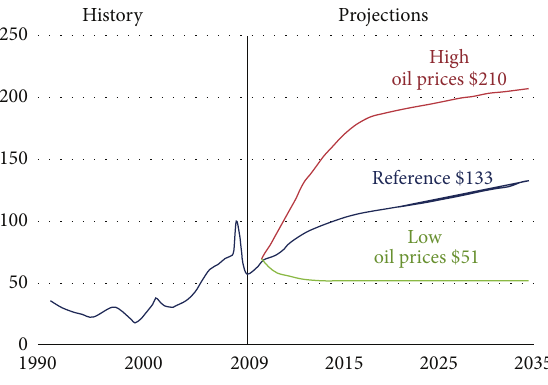
Figure 2: World fuel prices ($ per barrel).